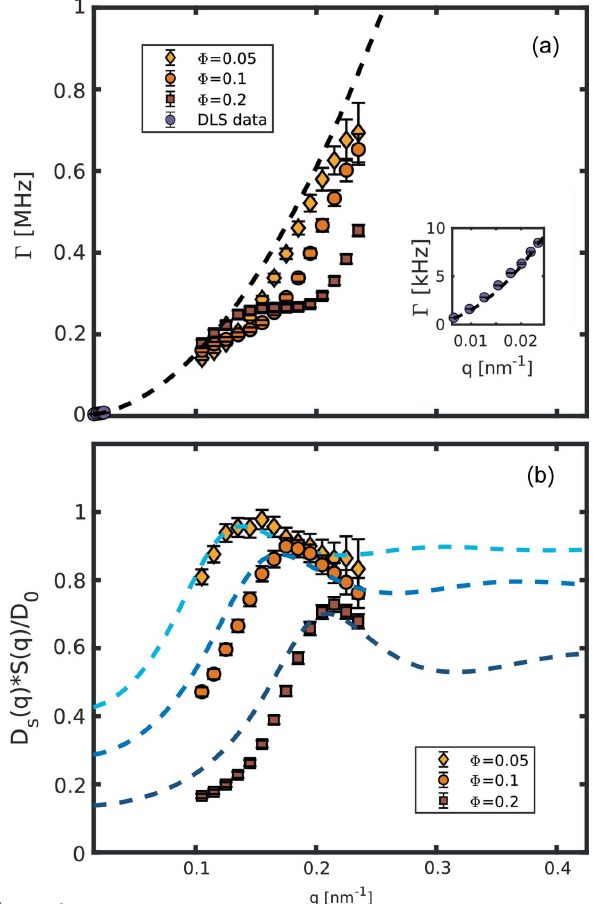
Figure 4 ( a ) Relaxation rates as a function of temperature for sample A (red squares), sample B (orange circles) and sample C (yellow diamond). The data are reported together with the pure diffusive behaviour (dashed line) extrapolated from DLS measurements on a diluted sample at 30 (cid:10) C (purple circles). The detail of the DLS data is reported in the inset. ( b ) Experimental HI for samples A, B and C as a function of q . The data points are reported with the respective H m ( q ) obtained from the analytical approximations reported by Westermeier et al. (2012) and Heinen et al. (2011 a